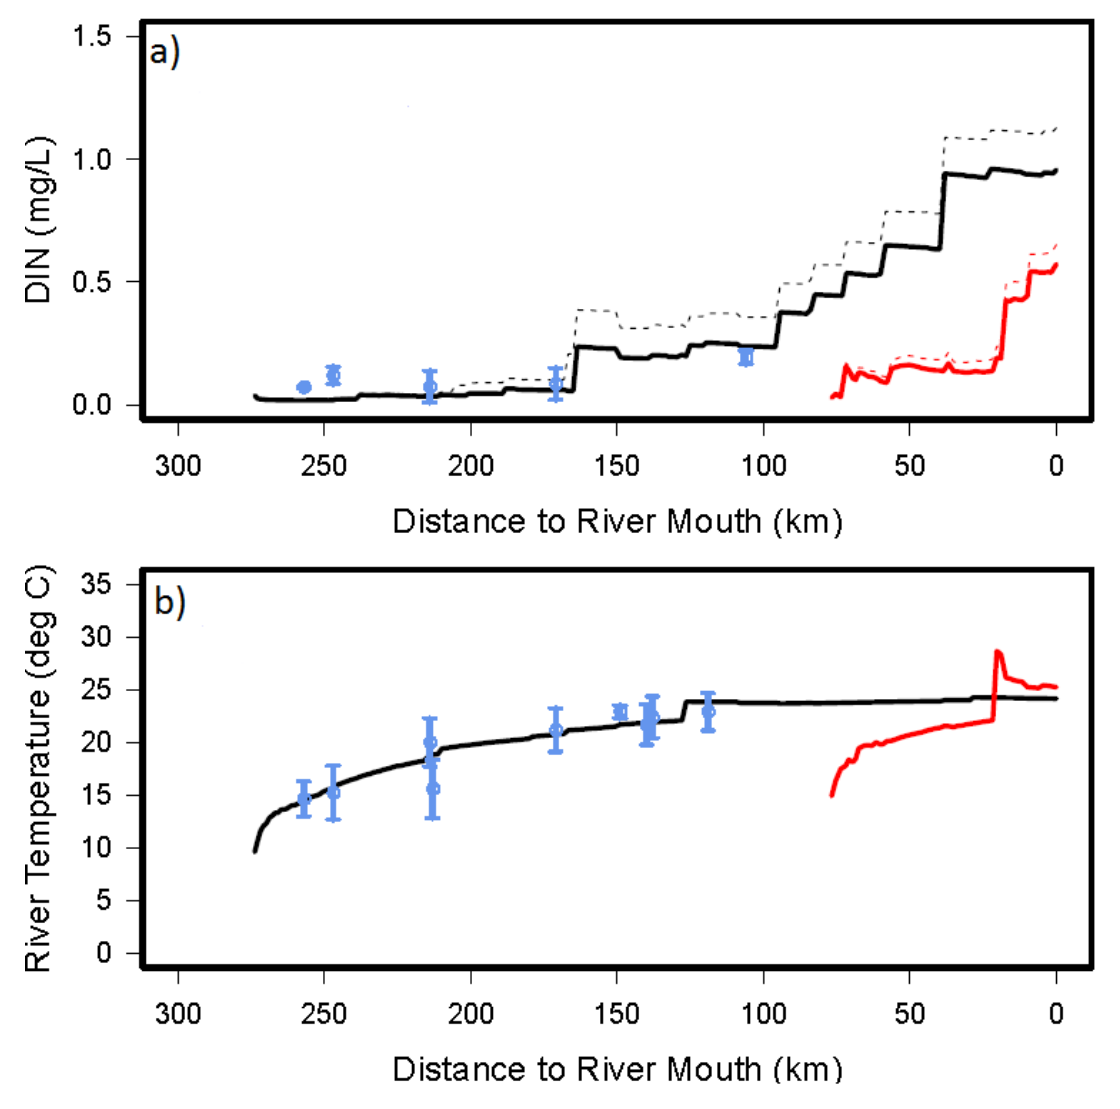
Fig. A4.3. Basin profiles (i.e. the longest flow path distance from the basin mouth to headwaters) for (a) DIN (mg/L), (b) river water temperature (deg C) and (c) specific conductivity (uS/cm) during mean summer conditions. The black and red lines represent coupled model results for the Merrimack and Piscataqua Rivers, respectively. Blue points show the mean and standard deviations for observations at LoVoTECS sites. The dotted line represents conservative mixing of DIN in a simulation without instream denitrification (Fig.